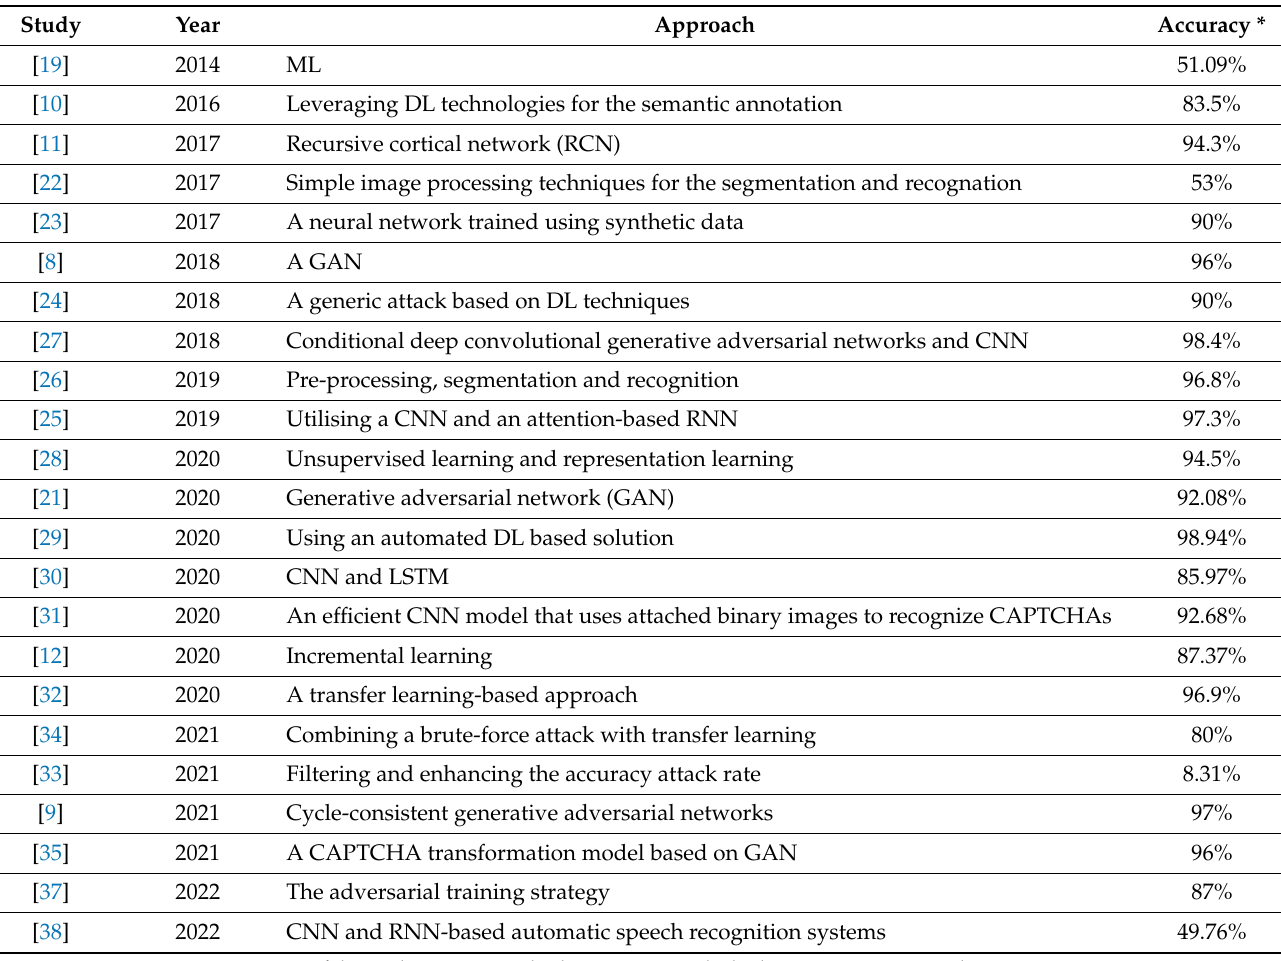
Table 1. Summarizing recent automatic CAPTCHA attack studies armed with different DL